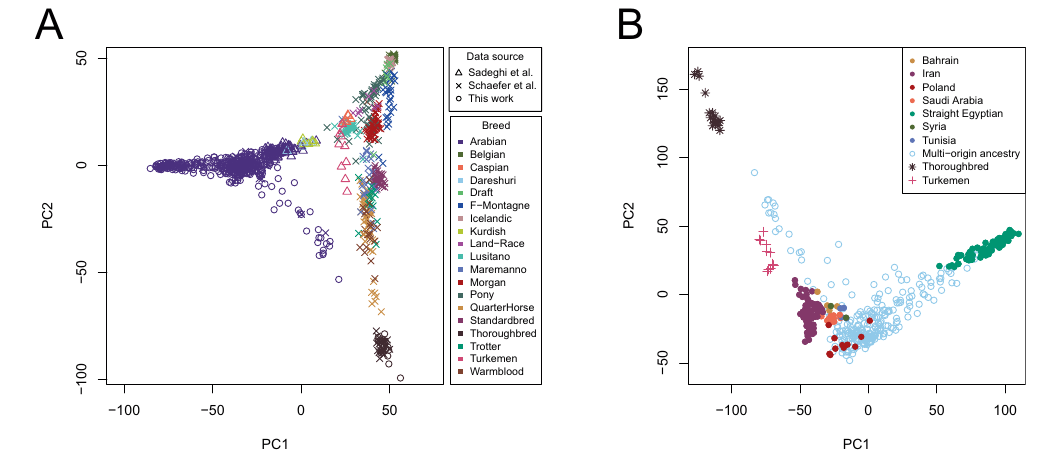
Figure 1. The Arabian is a distinct breed with diverse lineages, having little apparent relationship to the Thoroughbred. Principal component analysis of 378 Arabian horses sampled in this study ( A ) among a reference set including samples from 18 additional global breeds from 13 and 22 , with symbol shape indicating data source and symbol color indicating breed (data set: 917 samples across 30,967 SNPs); and ( B ) with 71 Persian Arabian and 11 Turkemen samples from 13 , and 17 Thoroughbred samples collected in this study, with symbol shape indicating breed, and symbol color indicating Arabian breed lineage, except for the Thoroughbred and Turkemen groups (data set: 477 samples across 56,239 SNPs). Percent variance explained: ( A ) PC1 = 5.6%, PC2 = 2.2%; ( B ) PC1 = 4.8%, PC2 = 2.5%. PC3 is plotted in Supplemental Figs. S2 and S3. See also Supplemental Fig. S4.